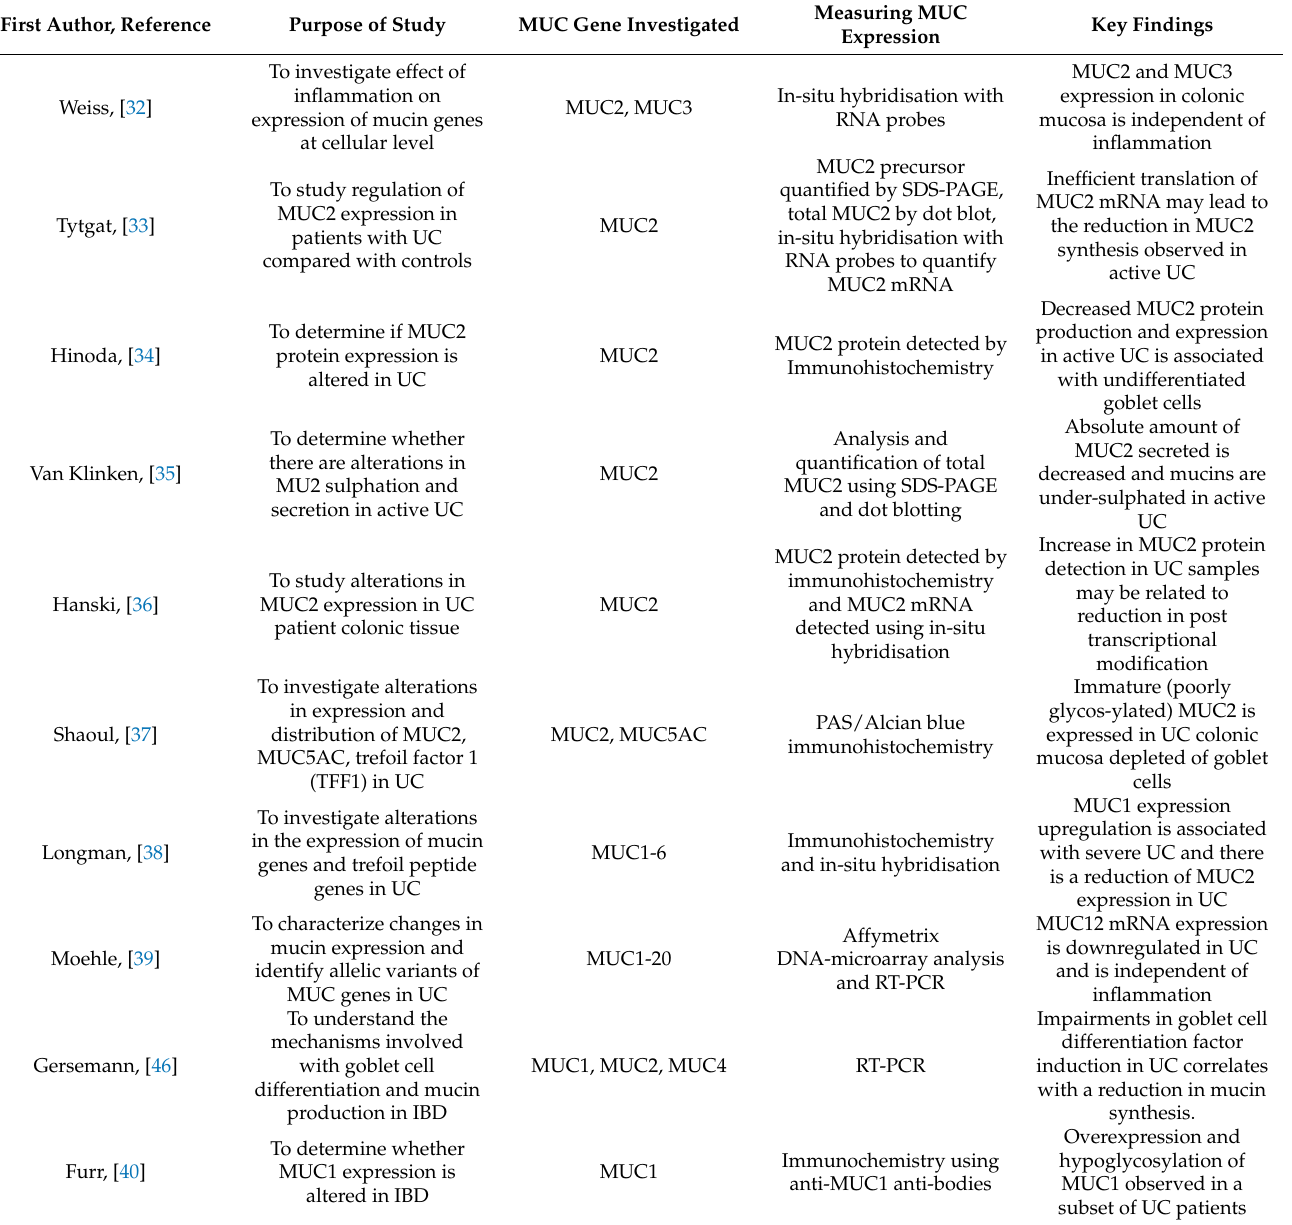
Table 2. Summary of the purpose for articles included for analysis and key